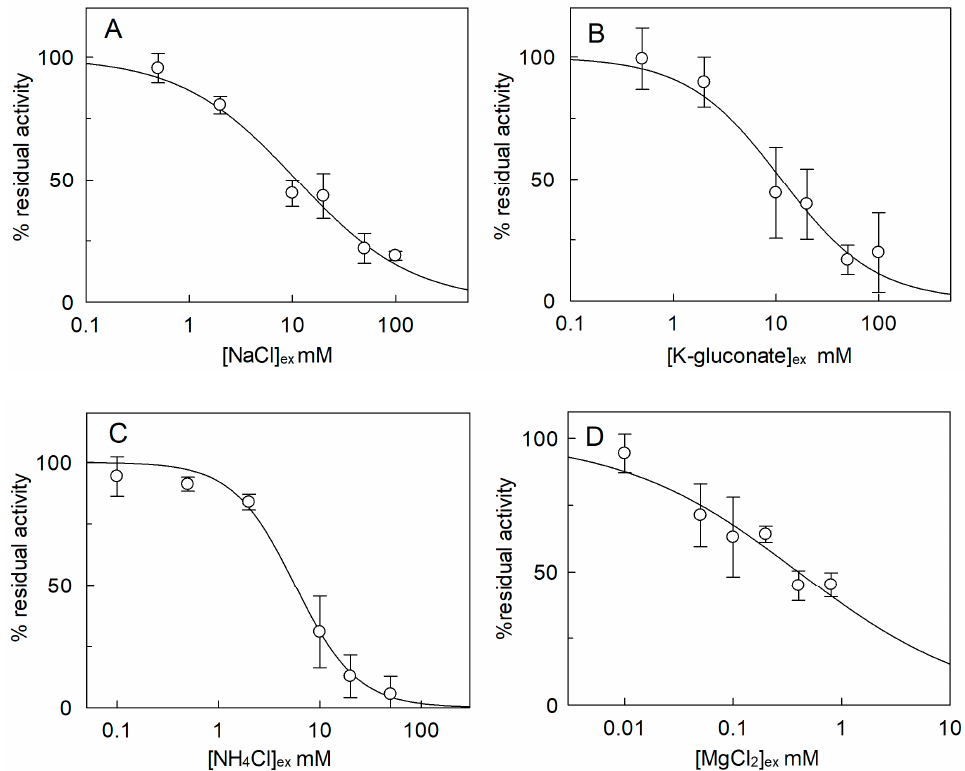
Figure 5. Dose–response curve for the inhibition of Sl CAT2 by external cations. Sl CAT2 was purified and reconstituted in proteoliposomes as described in Section 4.4. Transport was measured in 20 min, as described in Section 4.5, by adding 100 µ M [ 3 H]Arg together with the indicated concentrations of NaCl ( A ), K-gluconate ( B ), NH 4 Cl ( C ), or MgCl 2 ( D ) to proteoliposomes containing 200 mM sucrose and 15 mM ATP, at pH 7.5. Transport activity was calculated as the percent of residual activity with Int. J. Mol. Sci. 2019 , 20 , 906 means ± SD from three experiments.